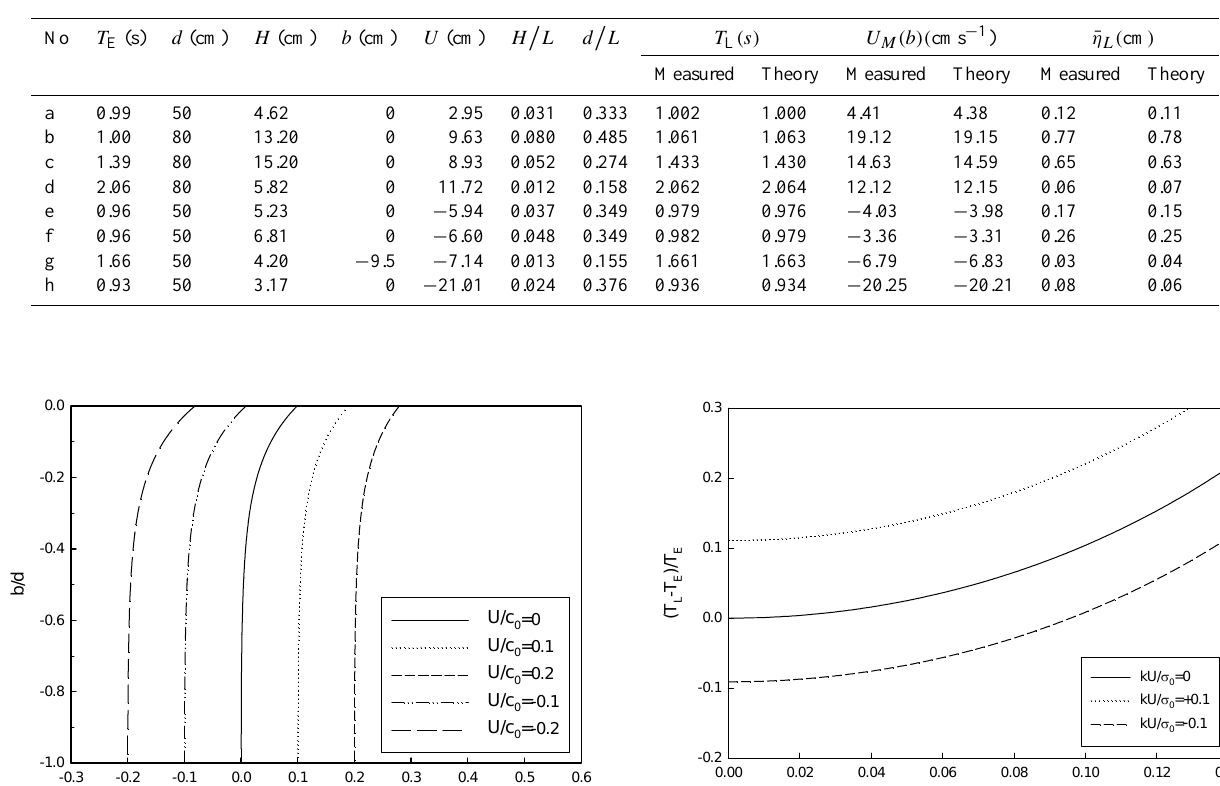
Table 1. Experimental conditions and comparison of measured and theoretical results of the particle period T L , mass transport velocity U M = ¯ x t − U and Lagrangian mean wave level ¯ η L .